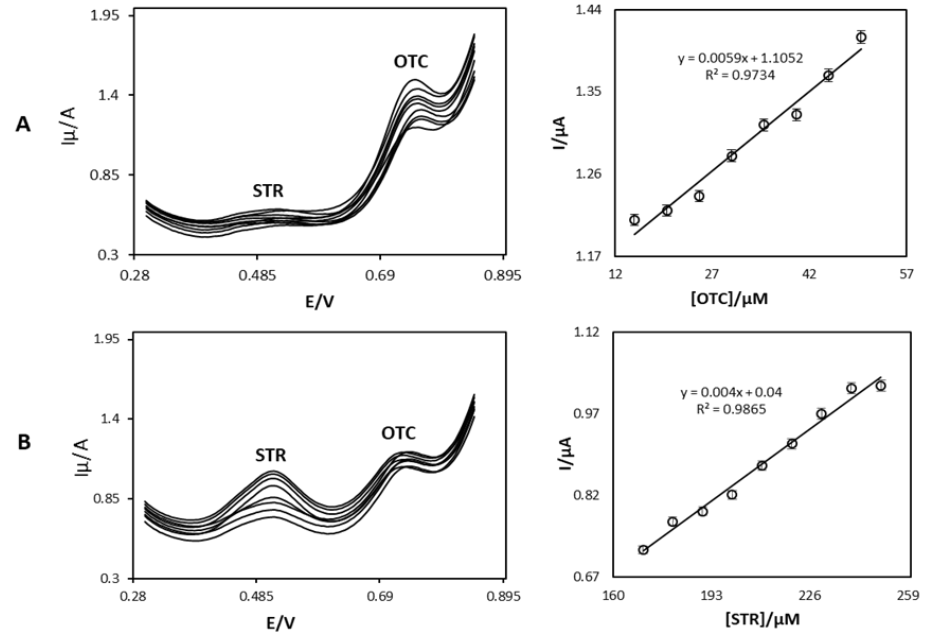
Figure 7. ( A ) Differential pulse voltammograms of OB/SNPs/GO/SPE in a 0.1 M phosphate buffer solution pH = 7.0 containing 15.0 µM OTC and different concentrations of STR. Numbers 1–9 correspond to 170.0, 180.0, 190.0, 200.0, 210.0, 220.0, 230.0, 240.0, and 250.0 µM STR, respectively. Inset shows the plot of the electrocatalytic peak current as a function of STR concentration within the 170.0–250.0 µM range. ( B ) Differential pulse voltammograms of OB/SNPs/GO/SPE in a 0.1 M phosphate buffer solution pH = 7.0 containing 170.0 µM STR and different concentrations of OTC. Numbers 1–8 correspond to 15.0, 20.0, 25.0, 30.0, 35.0, 40.0, 45.0, and 50.0 µM OTC, respectively. Inset shows the plot of the electrocatalytic peak current as a function of OTC concentration within the 15.0–50.0 µM range.